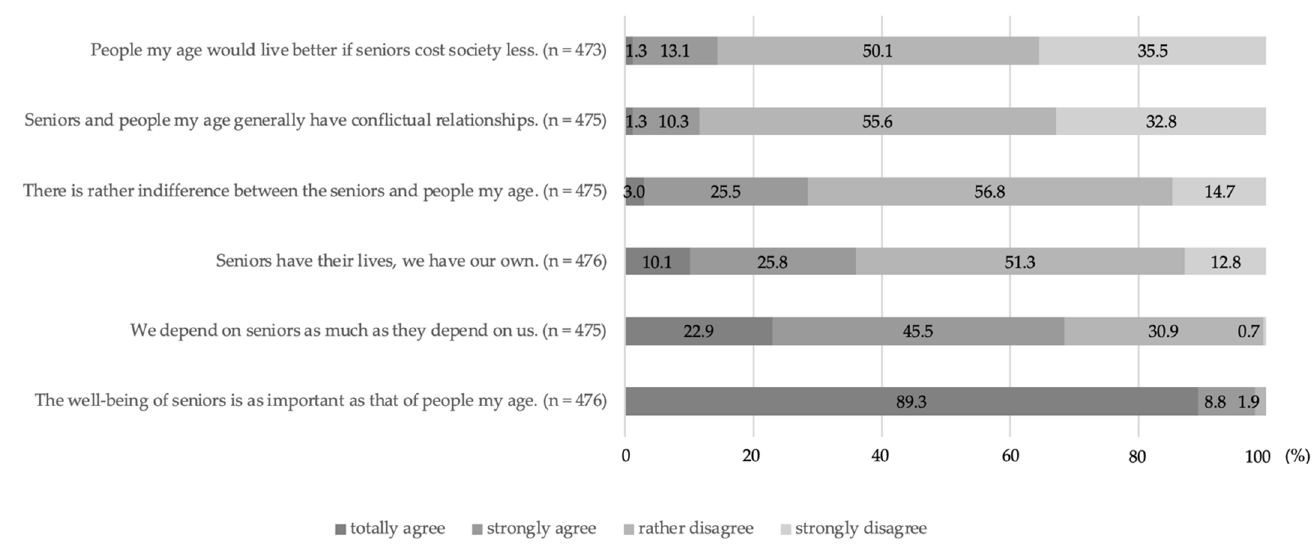
Figure 2. Dynamics of inter ‐ generational relations—total student responses (multiple answers possible).